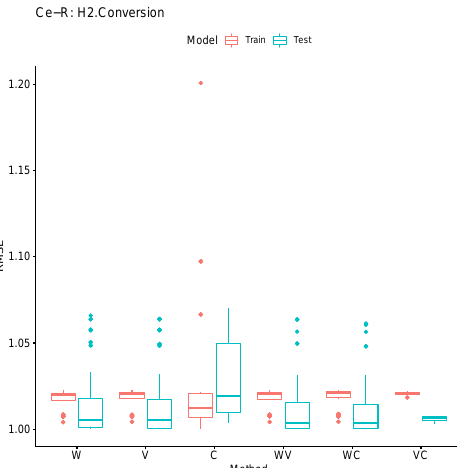
Figure 4. For predicting ESR products, the RMSE computed over the test and training data from all PLS models is compared. The data were divided into 70% train and 30% test for this purpose. This division was repeated 100 times, with the RMSE being recorded after each iteration.